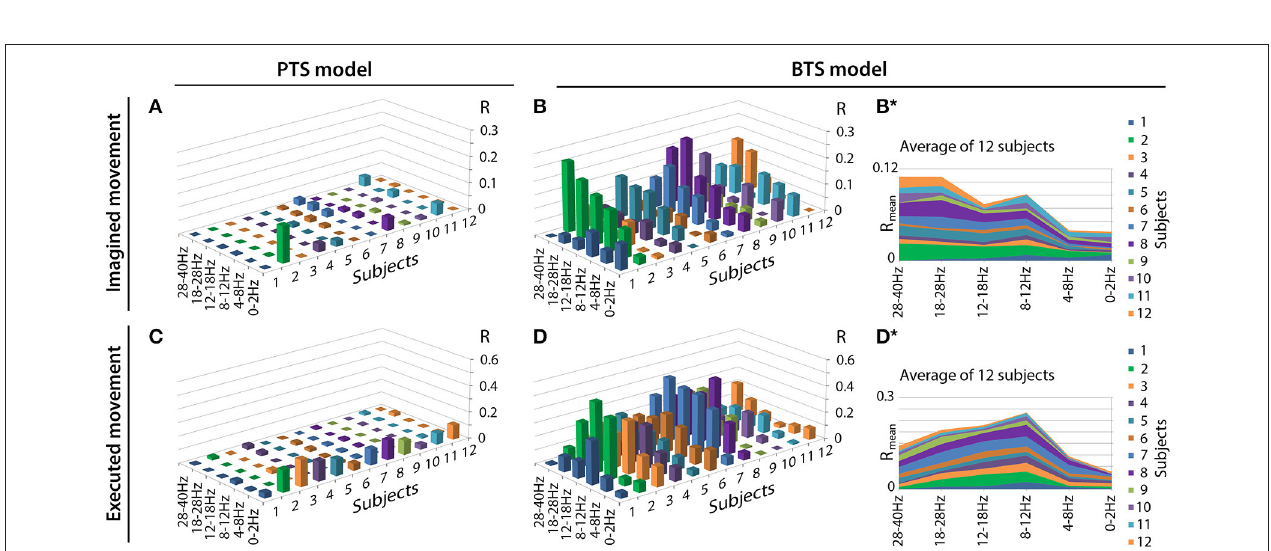
FIGURE 6 | Motion trajectory prediction accuracy using different models . Each displayed accuracy value is an average value based on the results of four runs, six outer folds, and three velocity components. Decoding accuracy values of imagined arm movements are presented in (A) for the band-pass filtered potential based PTS model and (B) for the PSD based BTS model. Reconstruction accuracy of executed arm movements is presented in (C) for the band-pass filtered potential based PTS model and (D) for the PSD based BTS model. For the BTS model, the cross-subject average of the reconstruction accuracy is presented in (B*) for imagined and in (D*) for executed movements (similar comparison of cross-subject mean values for the PTS results is not presented in this Figure as panels (A) and (C) show that the low delta band (0–2Hz) is the dominant band for each subject for the PTS model).